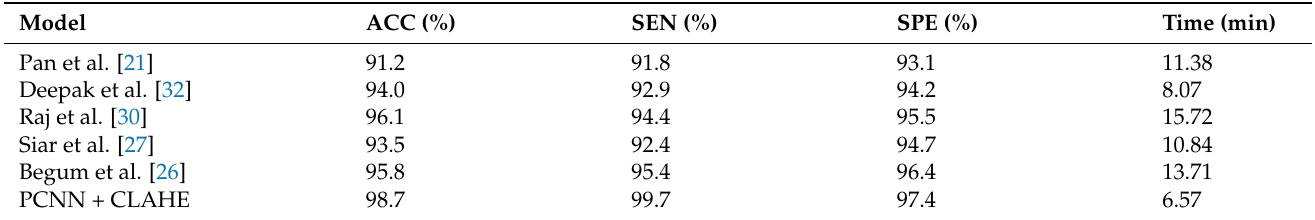
Table 5. Comparison table for the selected state of the art models using the same dataset and computing